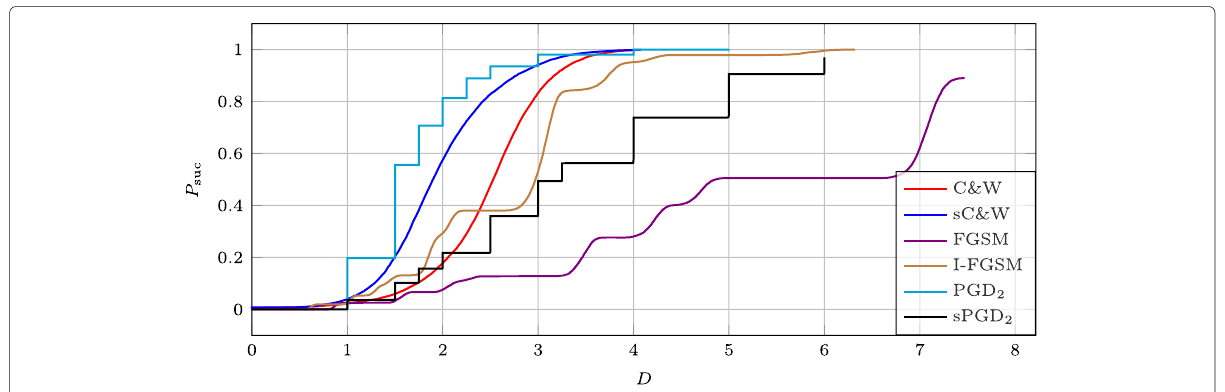
Fig. 5 Operating characteristics of the attacks over MNIST. Attacks PGD 2 and qPGD 2 are tested with target distortion D ∈ [1,6]